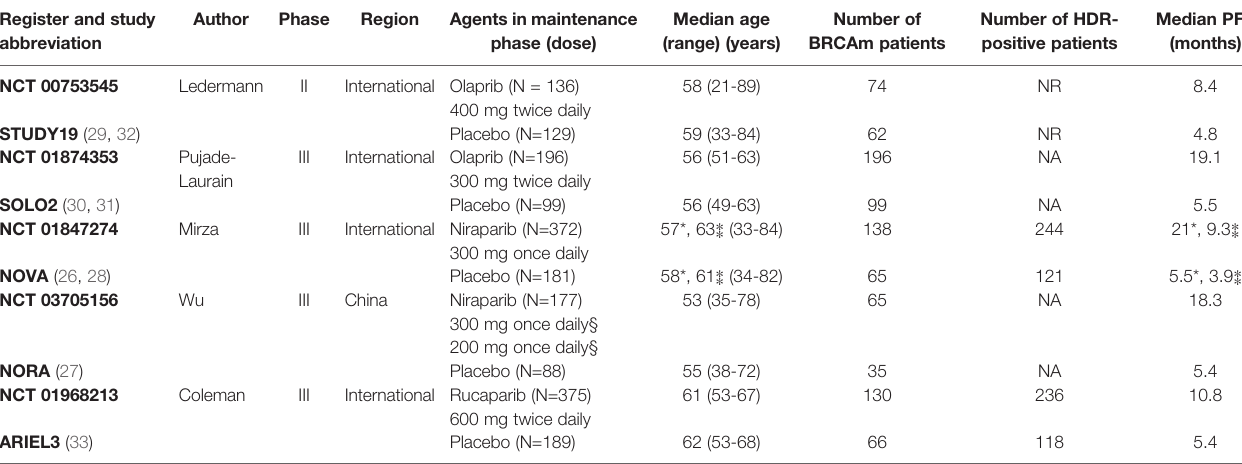
TABLE 1 | The basic characteristics of studies included in the